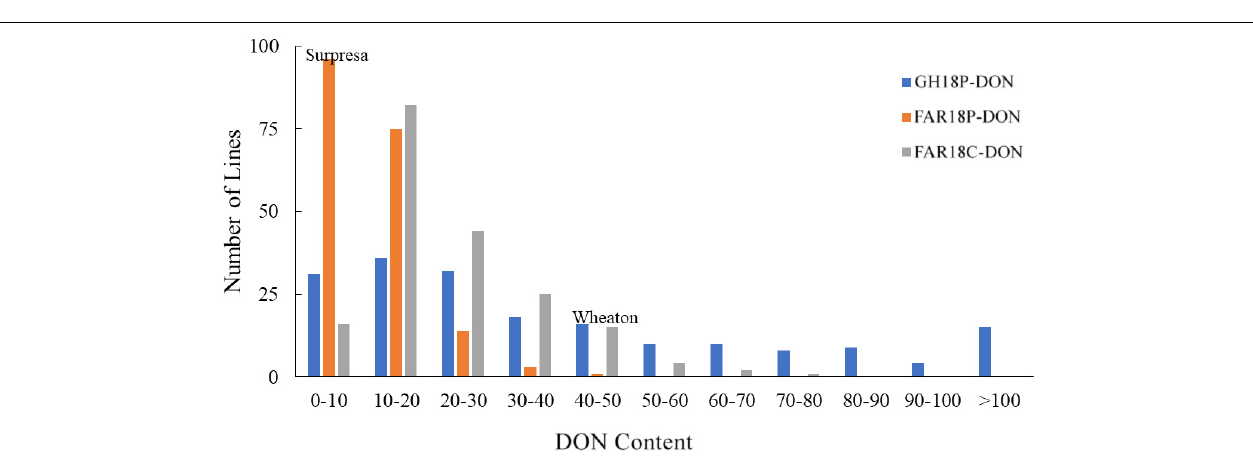
FIGURE 3 | Frequency distributions of deoxynivalenol (DON) content in the Wheaton/Surpresa RILs. DON content (expressed as parts per million, ppm) was assessed for grain samples of each line harvested from three FHB-inoculated experiments in 2018: GH18P, FAR18P, and FAR18C. The three DON testing experiments were designated as GH18P-DON, FAR18P-DON, and FAR18C-DON,